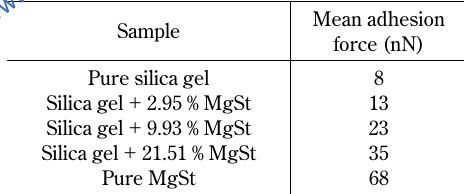
Table 2 Mean adhesion force (nN) for differ- ent particulate systems